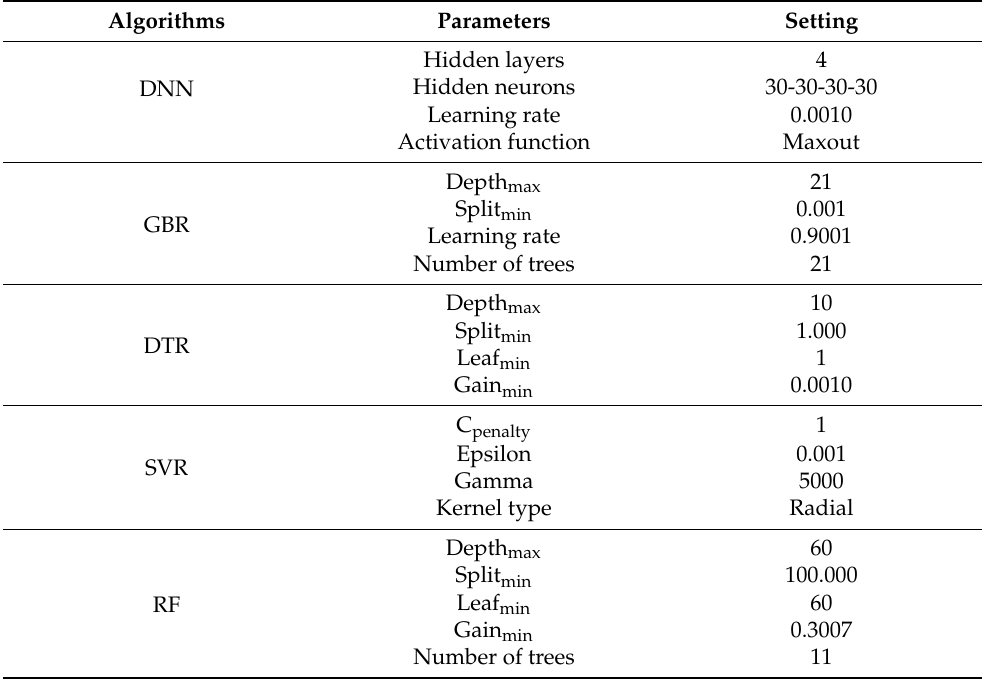
Table 3. Tuned parameters of the ML models employing